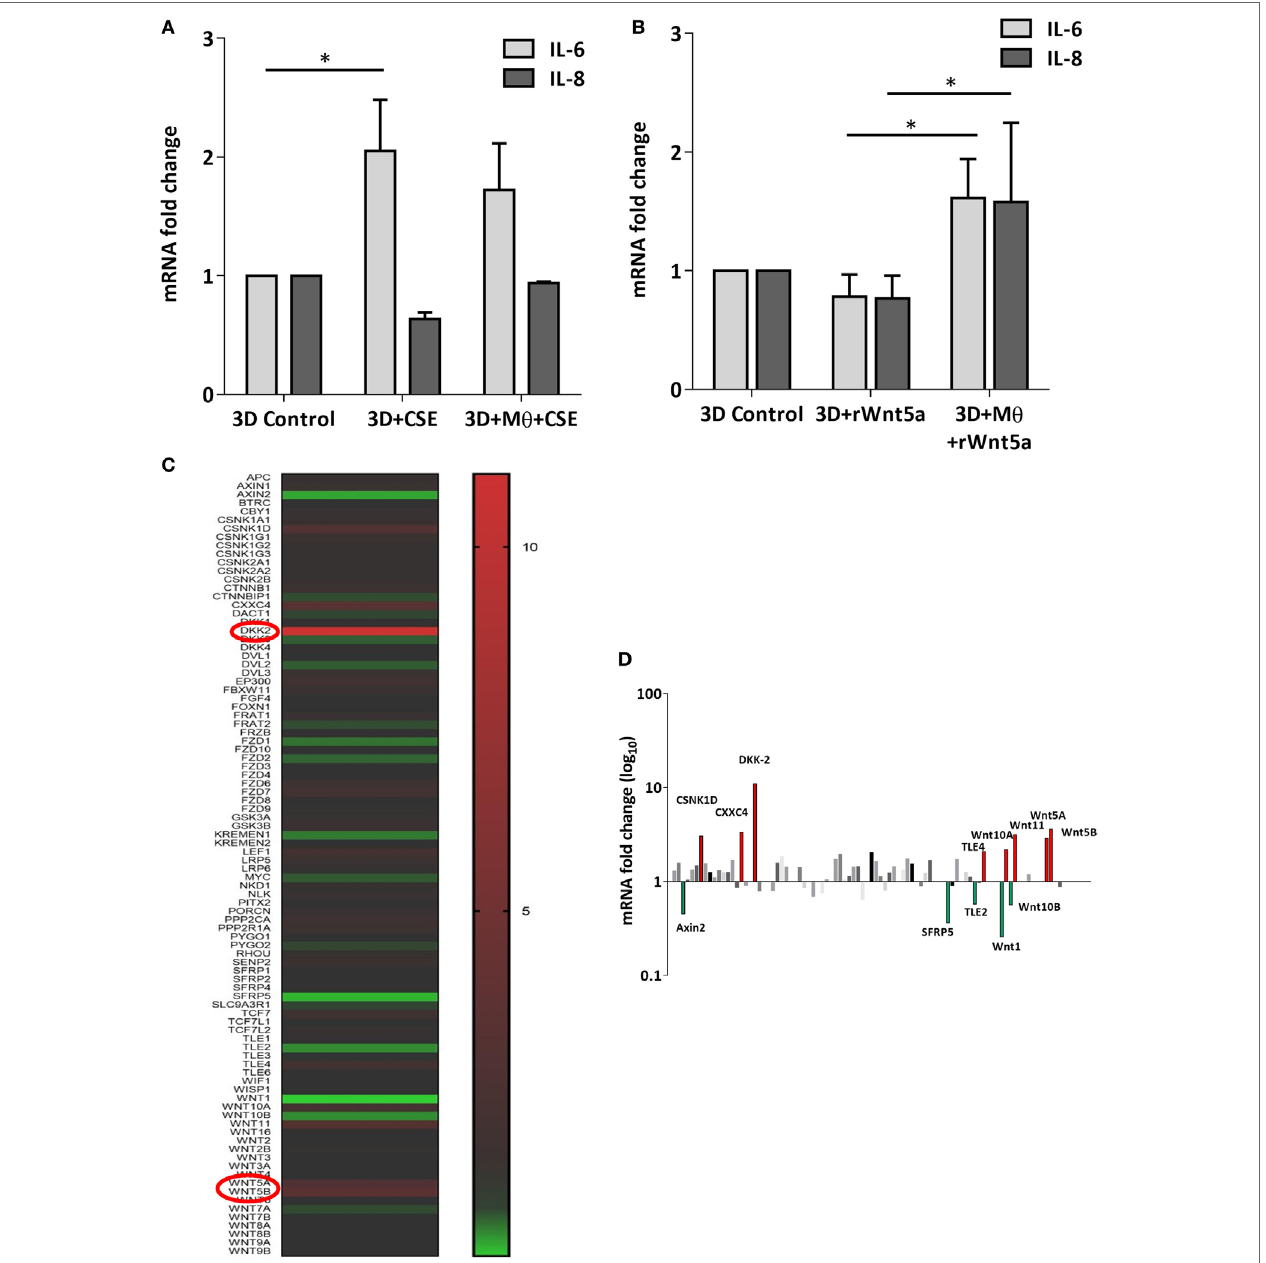
FigUre 3 | Inflammatory cytokine and Wnt mRNA levels in primary human 3D lung aggregate cultures and human macrophages (M) after cigarette smoke extracts (CSE) exposure. (a) IL-6 and IL-8 inflammatory cytokine mRNA levels in control and CSE exposed (48 h) lung aggregate cultures, containing and not containing M. (B) IL-6 and IL-8 inflammatory cytokine mRNA levels in control and rWnt5a (1 µg/ml) treated lung aggregate cultures, containing and not containing M. (c) Taqman array heat map analysis of pooled ( n = 4) cDNA of human M compared with control. M were treated with CSE for 3 h. (D) Changes in mRNA levels of Wnt signaling pathway genes measured by Taqman Array analysis using pooled ( n = 4) cDNA samples of human M compared with